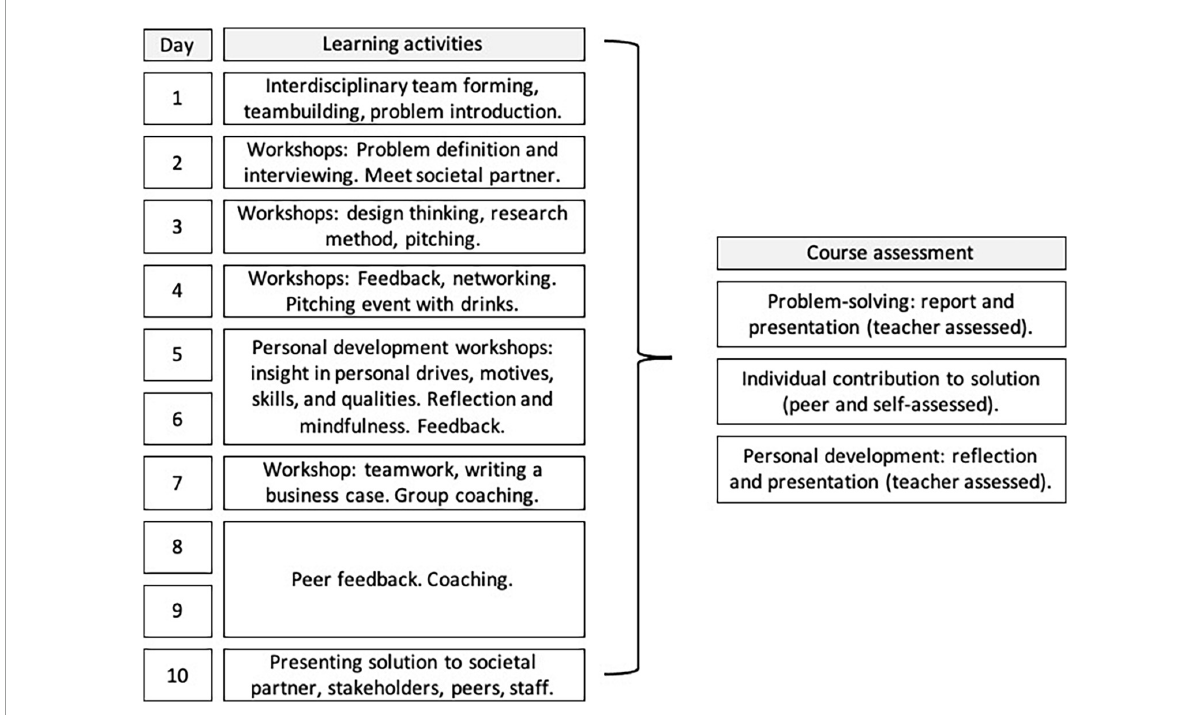
FIGURE1 Visual overview of the complex problem-solving case